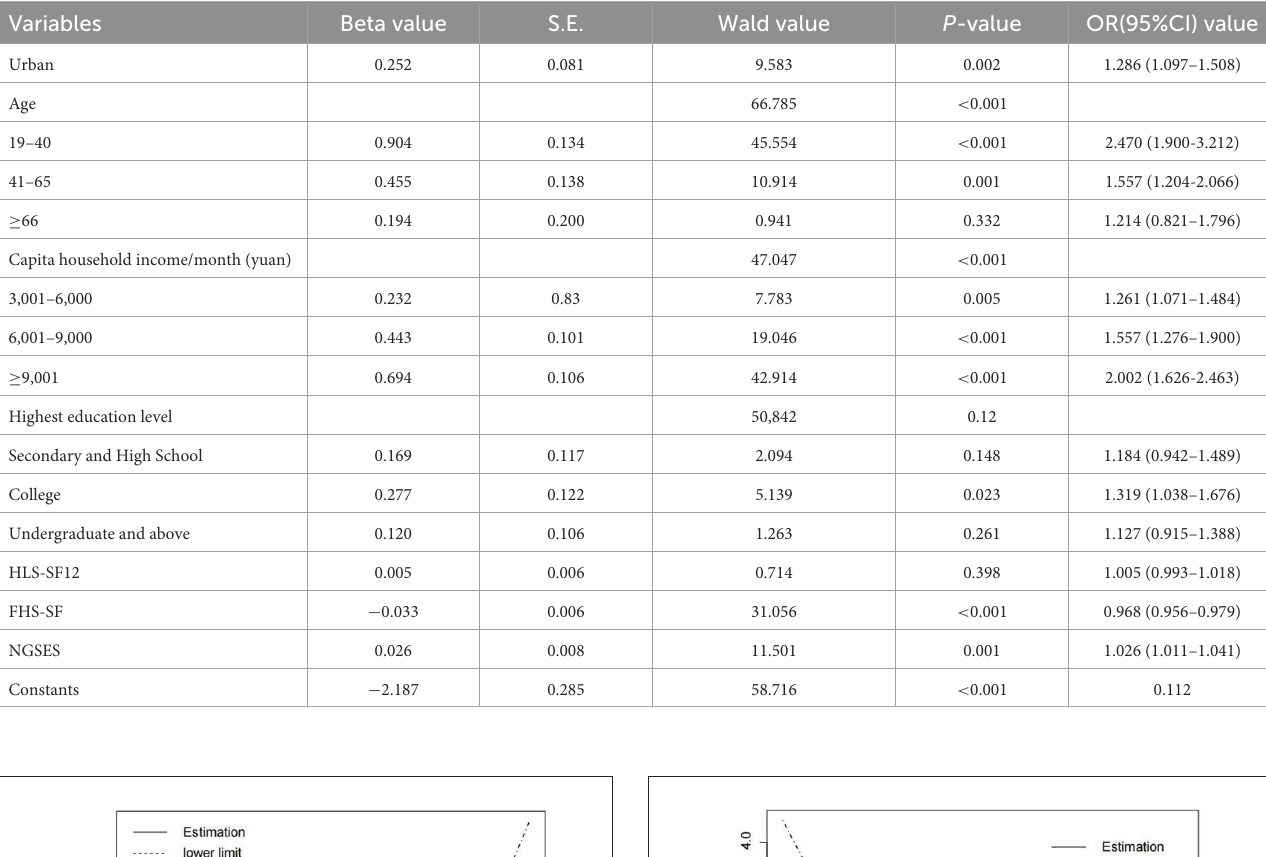
TABLE 3 Multifactorial logistic regression analysis of the effect of HPV vaccination.